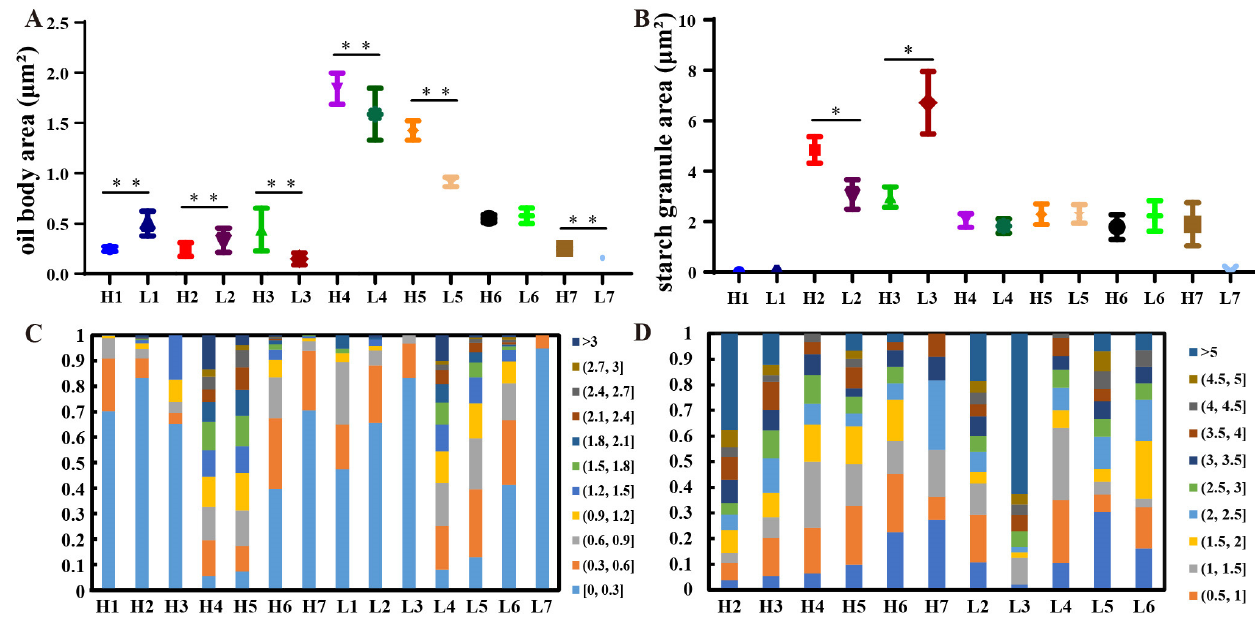
Figure 3. Differences in oil body and starch granule size in seeds at different developmental stages of HOC and LOC materials: ( A ), boxplot of oil body size for seeds at different stages. **, p < 0.01; ( B ) boxplot of starch granule size for seeds at different stages. *, p < 0.05; and ( C ), distribution of different sizes of oil bodies in developing seeds of N53-2 and Ken-C8. ( D ), distribution of different sizes of starch granules in developing seeds of N53-2 and Ken-C8. H1, H2, H3, H4, H5, H6, and H7 indicated seeds taken at 10, 17, 24, 30, 36, 42 and 48 days after fertilization in N53-2, respectively. L1, L2, L3, L4, L5, L6, and L7 indicated seeds taken at 10, 17, 24, 30, 36, 42 and 48 days after fertilization in Ken-C8, respectively.